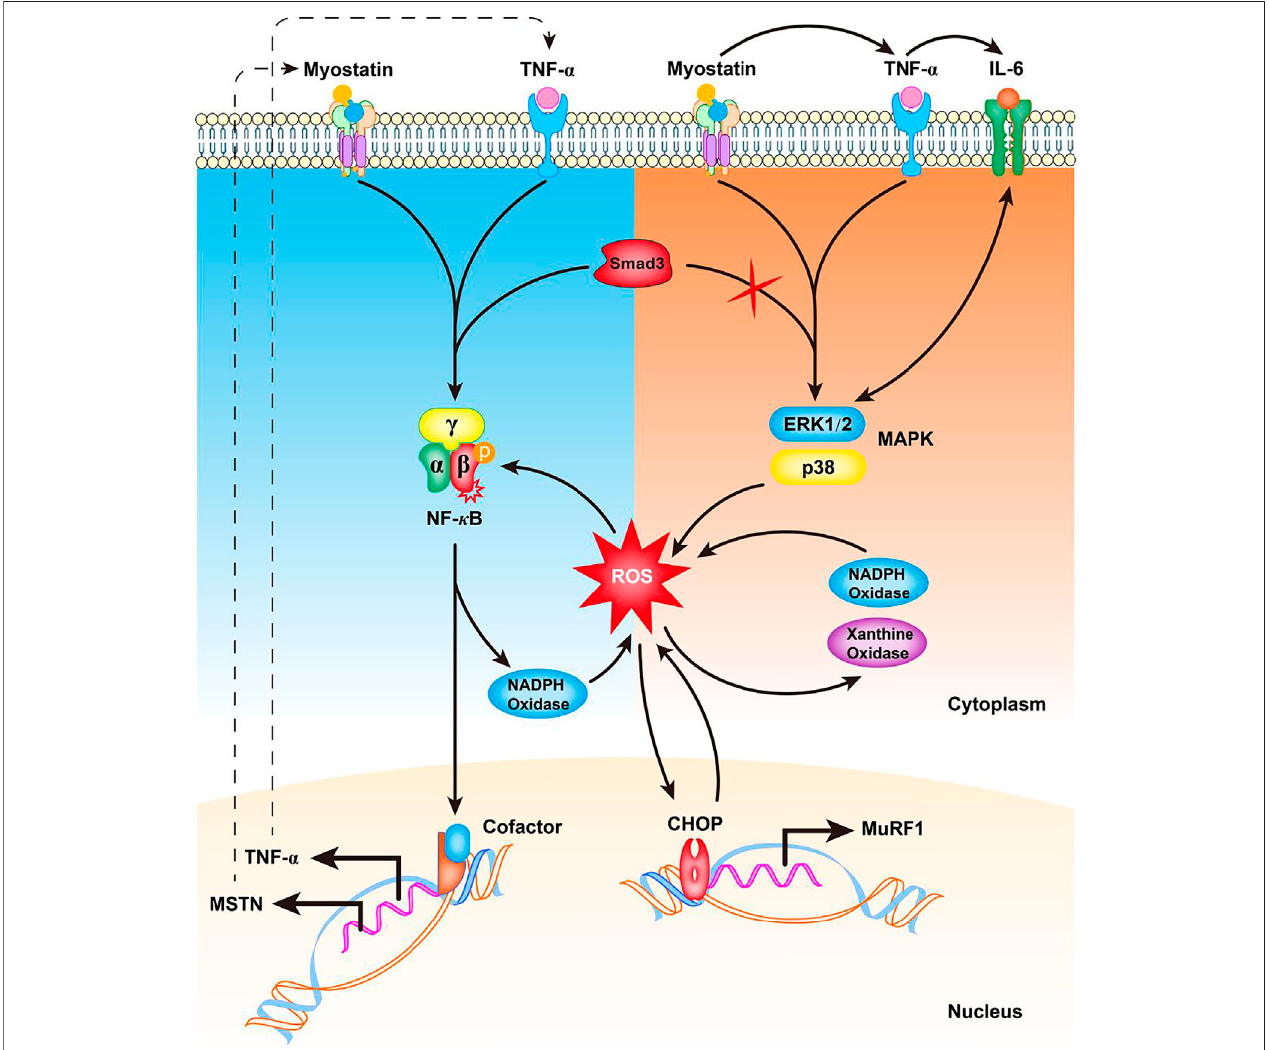
FIGURE 2 | Potential mechanism of myostatin-induced ROS generation in skeletal muscle. In the presence of Smad3, increased myostatin induces TNF- α production via NF- κ B signaling, increasing the production of ROS by NADPH oxidase. The induced ROS cause a feed forward loop, further increasing myostatin levels via NF- κ B signaling of TNF- α . In the absence of Smad3, myostatin induces TNF- α and IL-6 to activate p38 and ERK MAPKs to promote Nox- and XO-mediated ROS generation.TheinducedROSresultinincreasedC/EBPhomologousprotein(CHOP)levelsandup-regulationofMuRF-1transcription.AnincreasedCHOPprotein level in turn induces ROS production that further leads to increased myostatin production. TNF- α : tumor necrosis factor alpha; ROS: reactive oxygen species; NF- κ B: nuclear factor- κ B; IL-6: interleukin 6; Nox: NADPH oxidase; XO: xanthine oxidase; C/EBP: CCAAT/enhancer-binding protein.